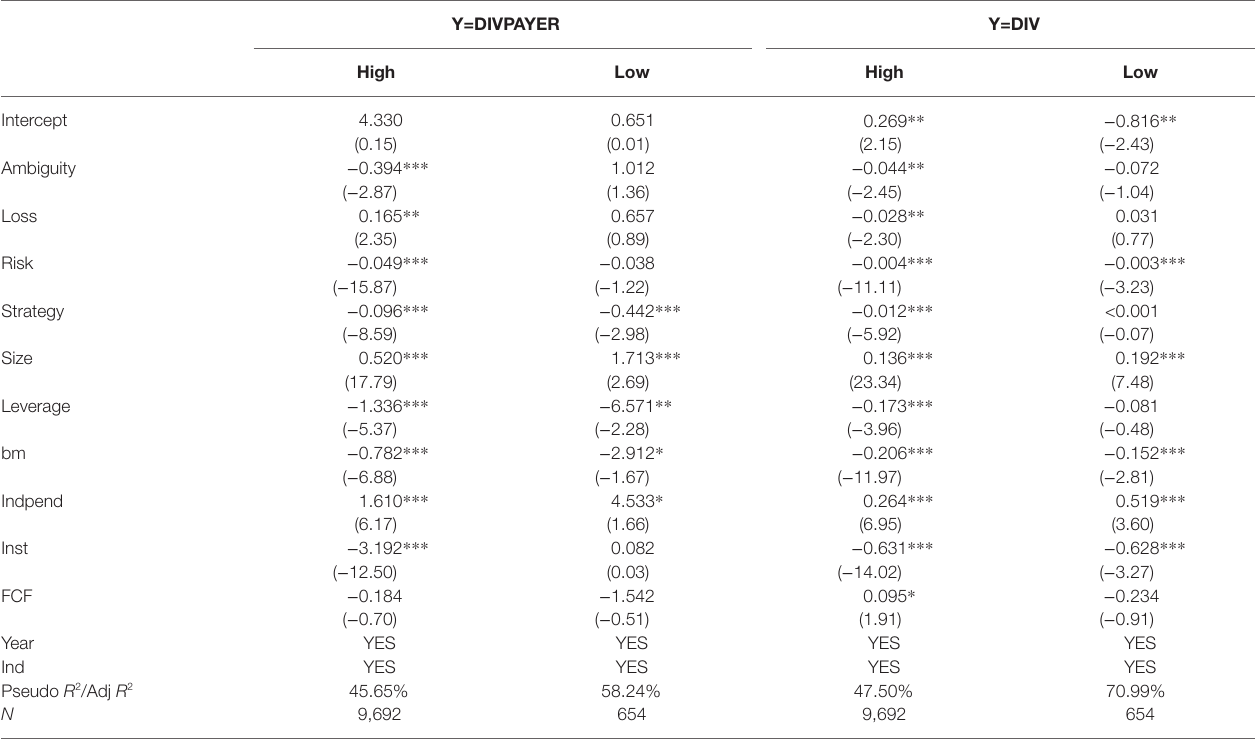
TABLE 9 | The effect of behavior foundations and business strategy on the dividend policy with high/low corporate